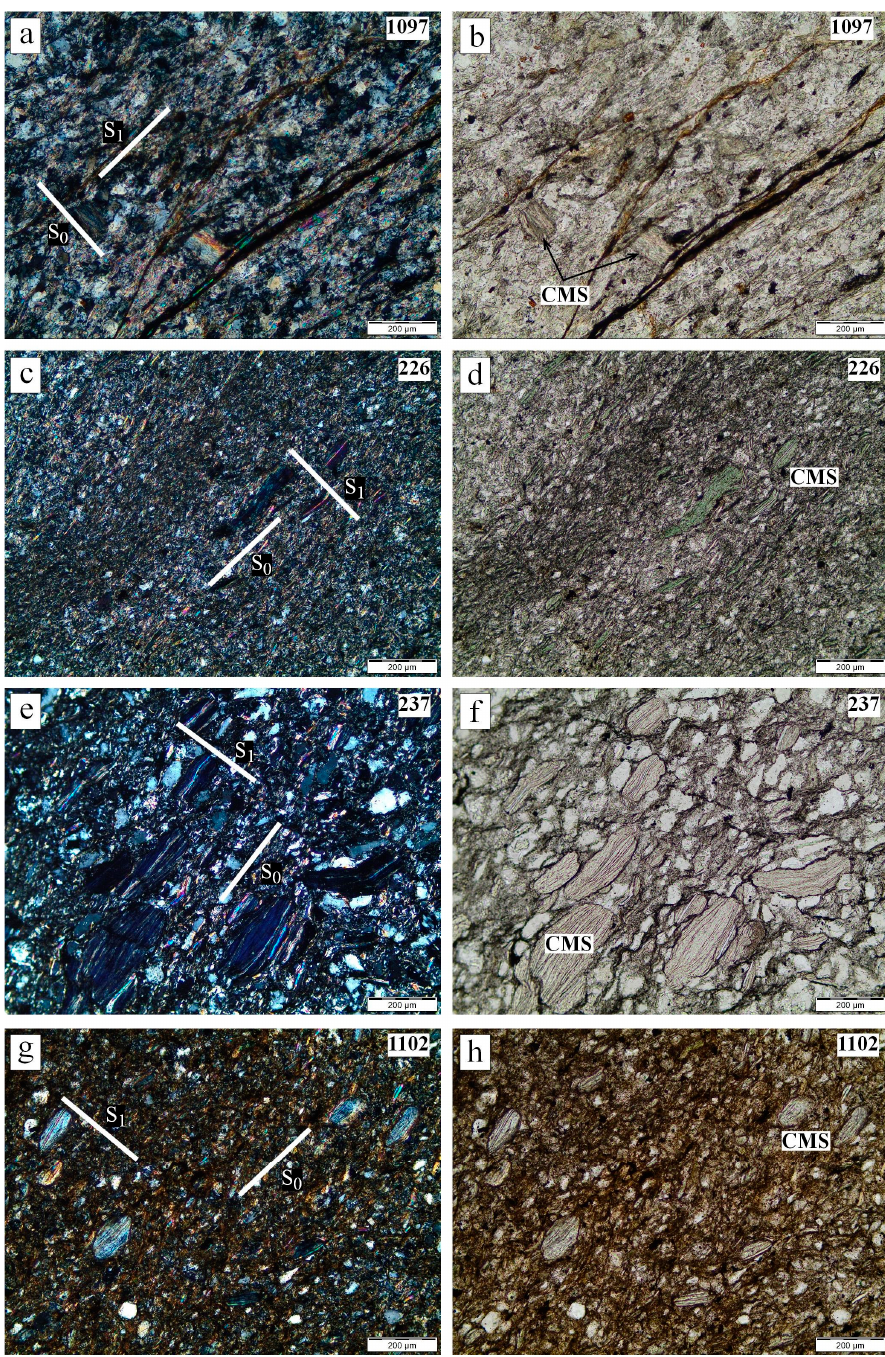
Figure 2. Photomicrographs of the Early Paleozoic siliciclastic rocks from the Geyik Da˘gı Unit in the Eastern Tauride Belt. Photos on the left were taken under crossed nicols, and on the right were taken under plane-polarized light. ( a , b ) Detrital CMS parallel to bedding planes (S 0 ) and perpendicular to slaty cleavage planes (S 1 ) in metasiltstone from Precambrian Emirgazi formation. ( c , d ) Chlorite-rich CMS; their long axes are parallel to S 0 and perpendicular to S 1 in chlorite slate from lower parts of early Ordovician Seydi¸sehir formation, ( e , f ) Abundant chlorite-rich CMS which is parallel to S 0 in the anchimetamorphic sandstone from the lower–middle part of the Seydi¸sehir formation, ( g , h ) White K-mica-rich CMS in silty slate from the late Ordovician ¸Sort Tepe